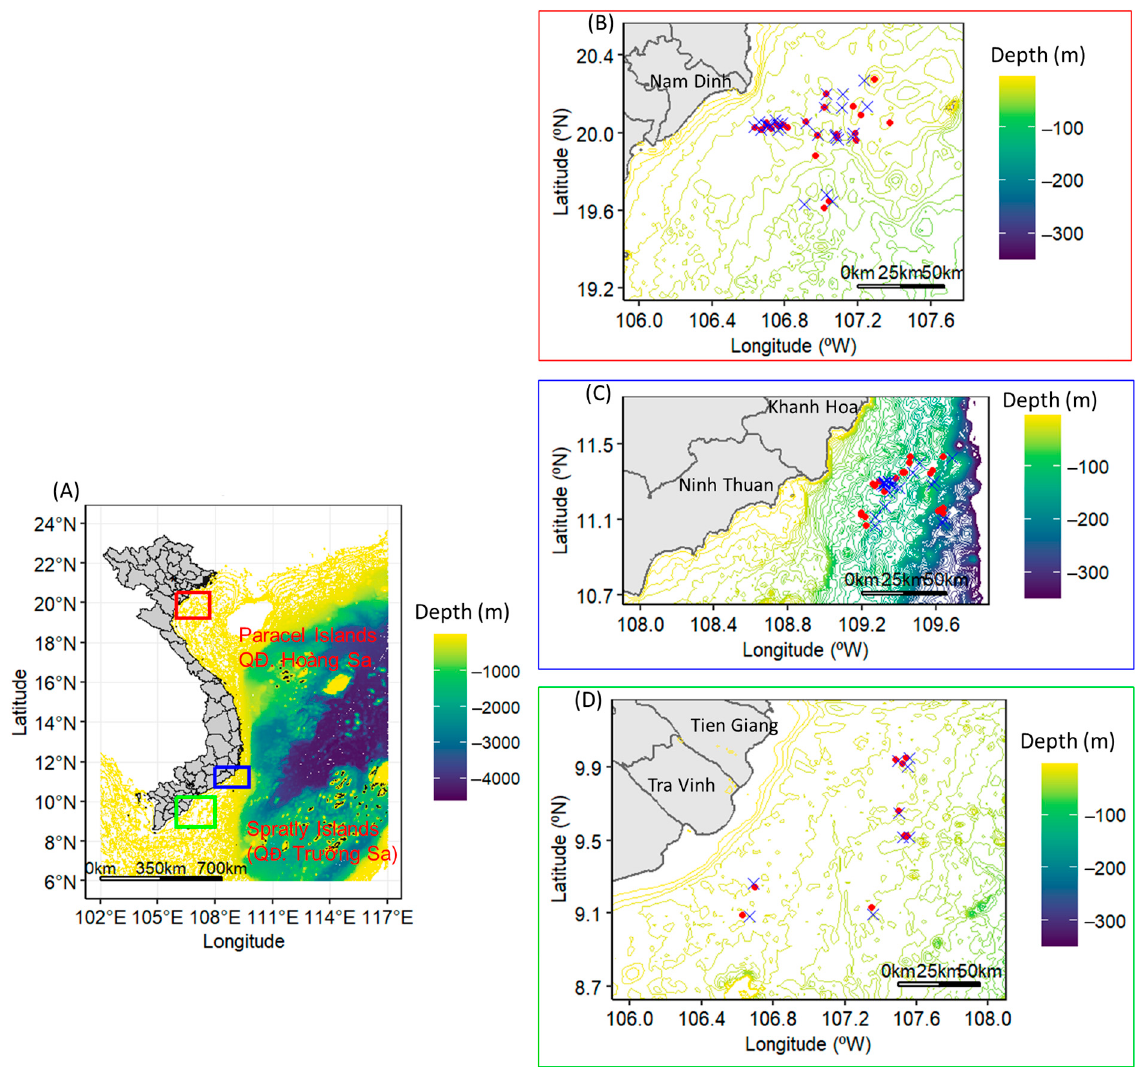
Figure 1. Map of Vietnam ( A ) including Gulf of Tonkin (red rectangular), center (blue rectangular), and south (green rectangular) study sites, and insets zoomed in on right ( B – D ) represent those study sites, respectively. Each blue x and red dot in the right panels indicates the location of a set of control gillnets and experimental gillnets, respectively, that were deployed during the study.